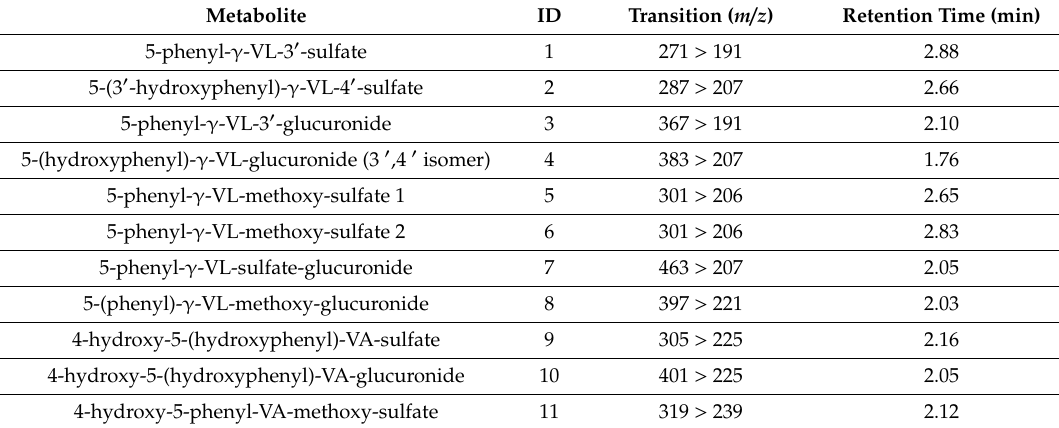
Table 2. Conjugated PVL and PVA detected in the urine of 11 study participants with the transition used for their quantitation and their retention times. VL: valerolactone; VA: valeric